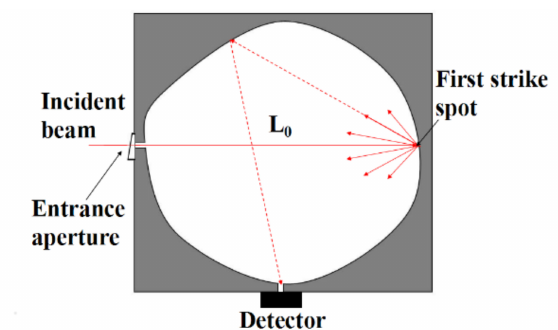
Figure 1. Simplified model of the radiation transmission process in an arbitrary integrating cavity.